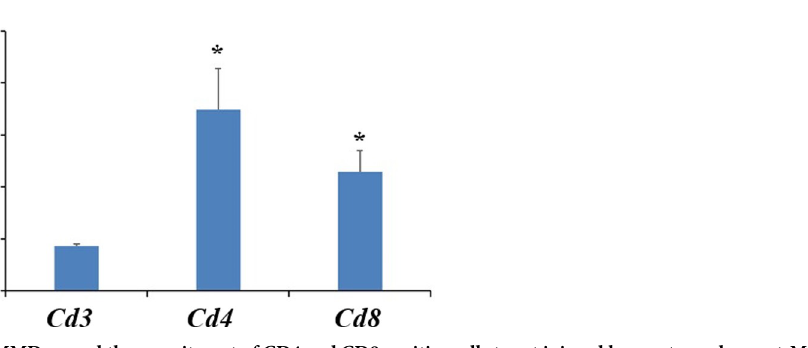
Fig 4. MMD caused the recruitment of CD4 and CD8 positive cells to rat injured knees at one day post-MMD. Quantification of mRNA expression levels for the markers of three T cell subsets isolated from rat knee joint synovial tissue, at one day post-surgery. Both right MMD-operated knees and left sham-operated knees (Lk) were collected. Data are expressed as fold change vs control sham-operated knees and are presented as mean ± SE, n = 4–5, � P < 0.05 vs control sham-operated knees (Lk).